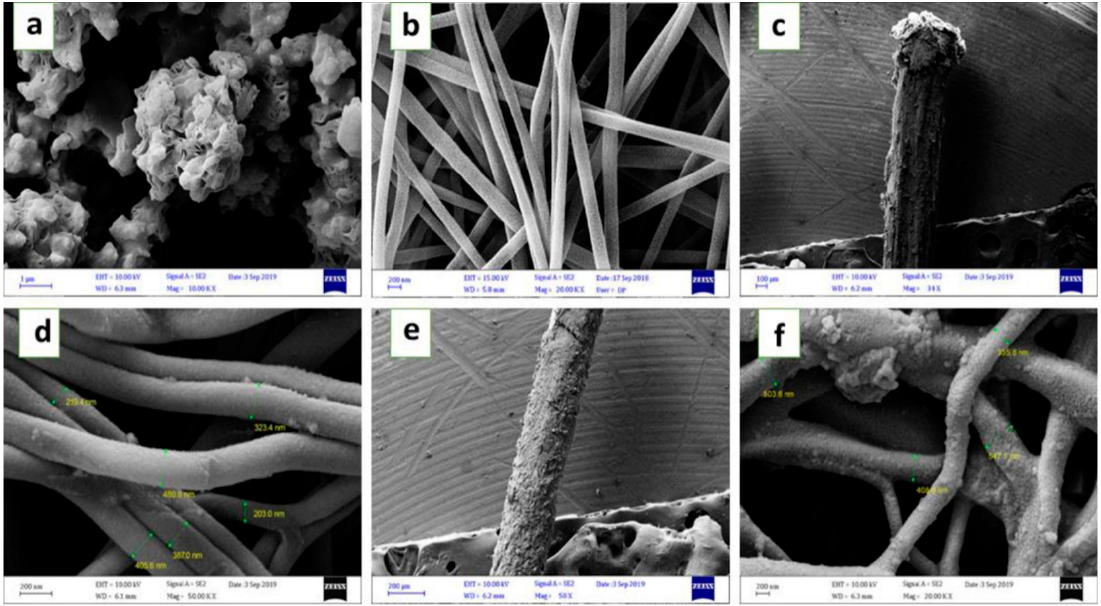
Figure 6. FESEM images of ( a ) Ni-MOF particles synthesized by hydrothermal method; ( b ) PAN nanofibers; ( c , d ) PAN/Ni-MOF composite nanofibers before extraction in different magnification; ( e , f ) electrospun PAN/Ni-MOF nanofibers after 160 times extraction in different magnification. Reprinted with permission from Ref. [90]. Copyright (2021) Elsevier.